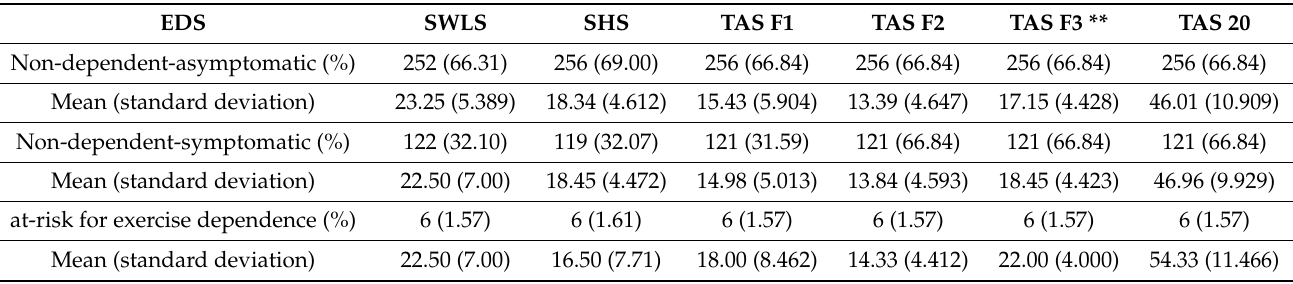
Table 3. Summary of cases EDS/SWLS, SHS, TAS 20.